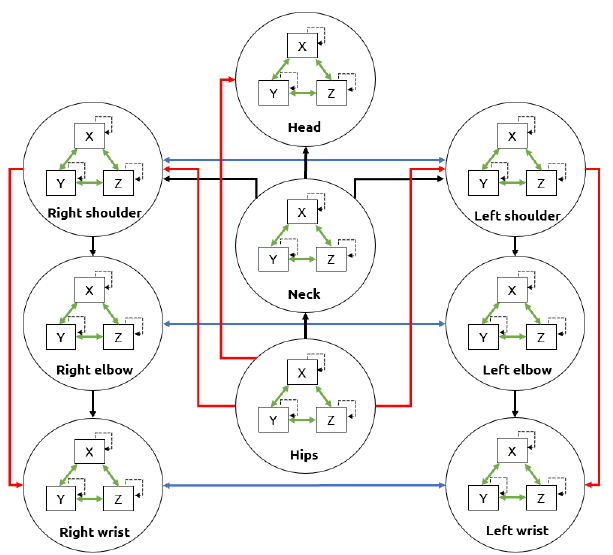
Figure 6. Upper-body assumptions that constitute a Gesture Operational Model. The intra-joint association is indicated by green arrows, transitioning over time with dashed arrows, inter-limb synergies with blue arrows, intra-limb serial mediation with black arrows, and intra-limb non-serial mediation with red